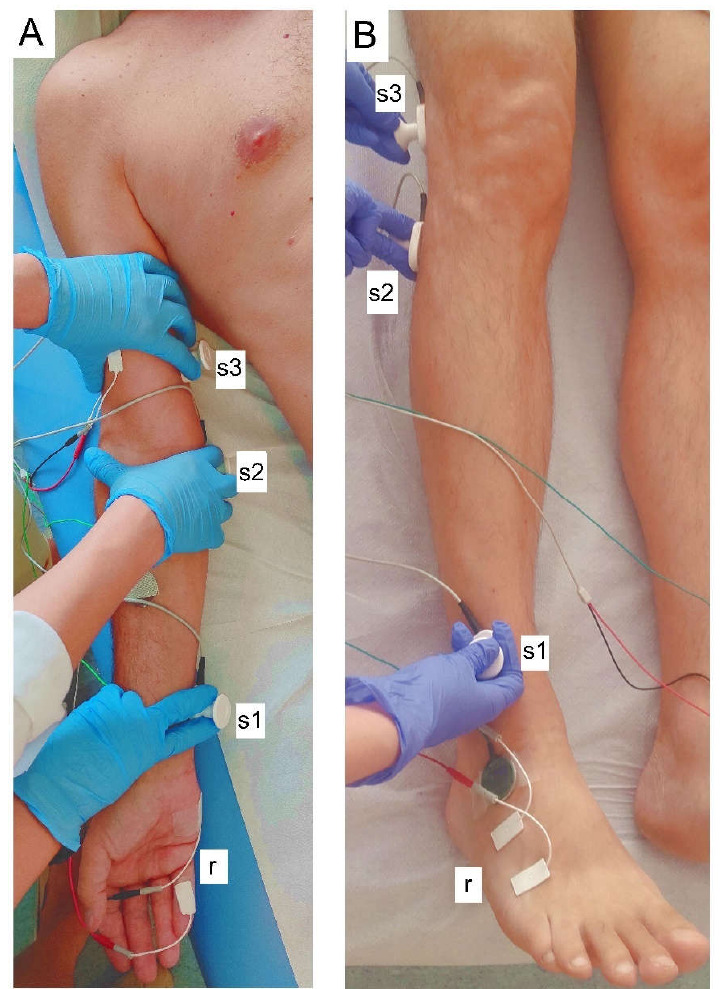
Figure 3. Principles of neurophysiological ENG studies in healthy volunteers and post-stroke patients. Figures show the sites of electrical stimulations via bipolar electrodes (s1–s3) and recordings (r) during ENG studies of neural transmission in the ulnar nerve ( A ) (s1, at the wrist; s2, at the ulnar sulcus; s3, above the elbow; and r, from abductor digiti minimi muscle) and peroneal ( B ) (s1, at the ankle; s2, below popliteal fossa; s3, above the popliteal fossa; and r, from extensor digitorum brevis muscle) nerves. Table 2. Characteristics of the subjects and the summary of applied electrotherapy parameters.